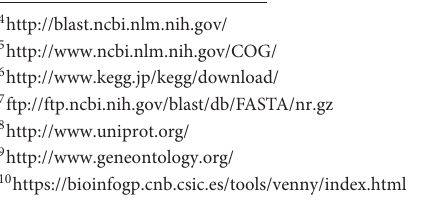
flow cytometry is presented in Figure 1 . The